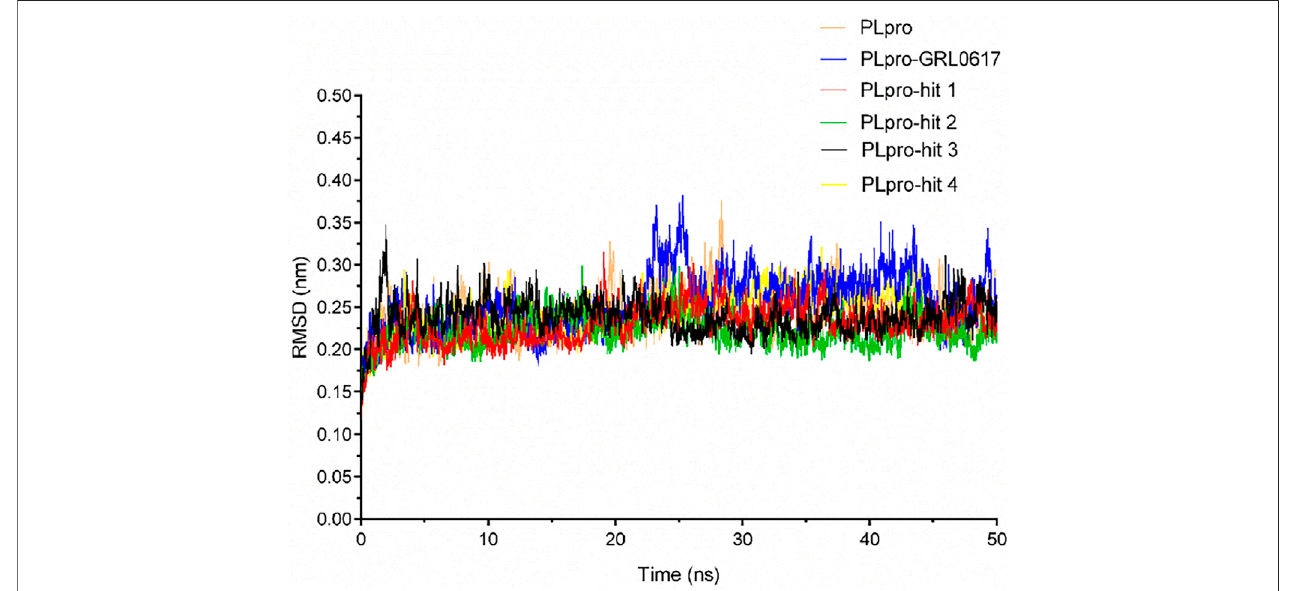
FIGURE 4 | Stability parameter of PLpro alone and PLpro in complex with GRL0617, hit 1, hit 2, hit 3, and hit 4 during 50 ns simulations. Backbone root mean square deviation (RMSD) of MD simulated complexes over the time scale of 50 ns.